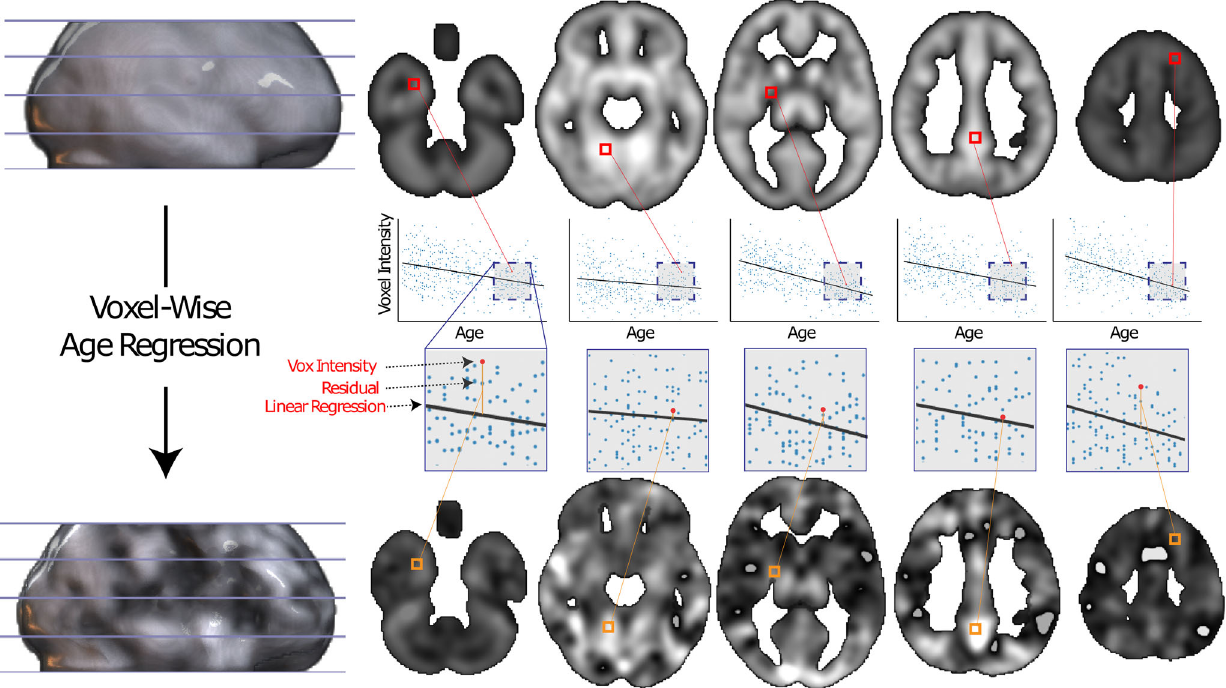
Fig. 3 An example of our voxel-wise age regression method. Red inset indicates the original voxel characteristics including intensity and location. Linear regression lines represent the linear fi t between age and voxel gray matter from participants. Orange insets indicate the regression residual, which is used as the new transformed age regressed voxel